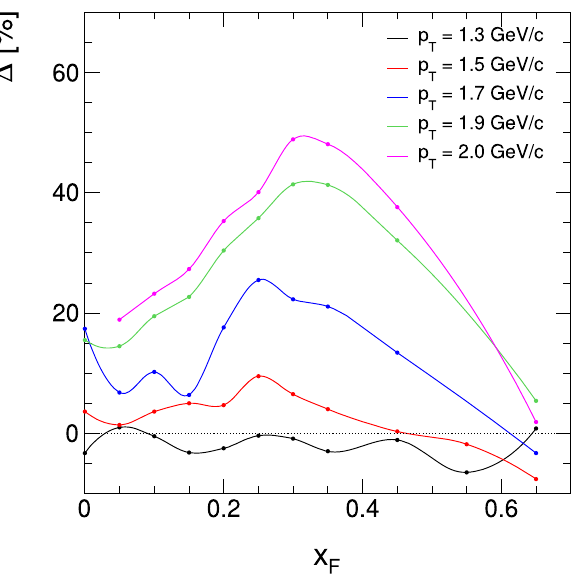
Fig. 188 Percent deviation between data and resonance sum as a func- tion of p T for x F = 0.2, 0.25, 0.3 and 0.35